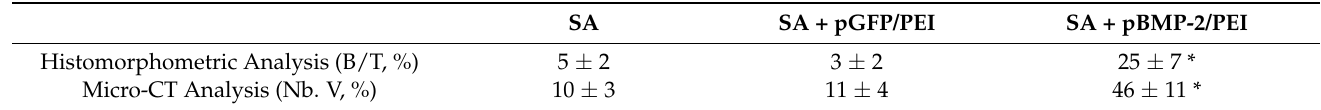
Table 2. Comparative assessment of the new bone formation degree using histomorphometric and micro-CT analyses at 8 weeks after SA scaffold